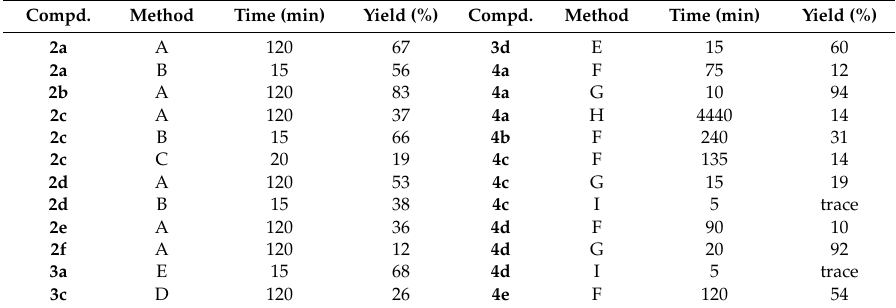
Table 4. Reaction data from the di ff erent synthetic methods of novel compounds.